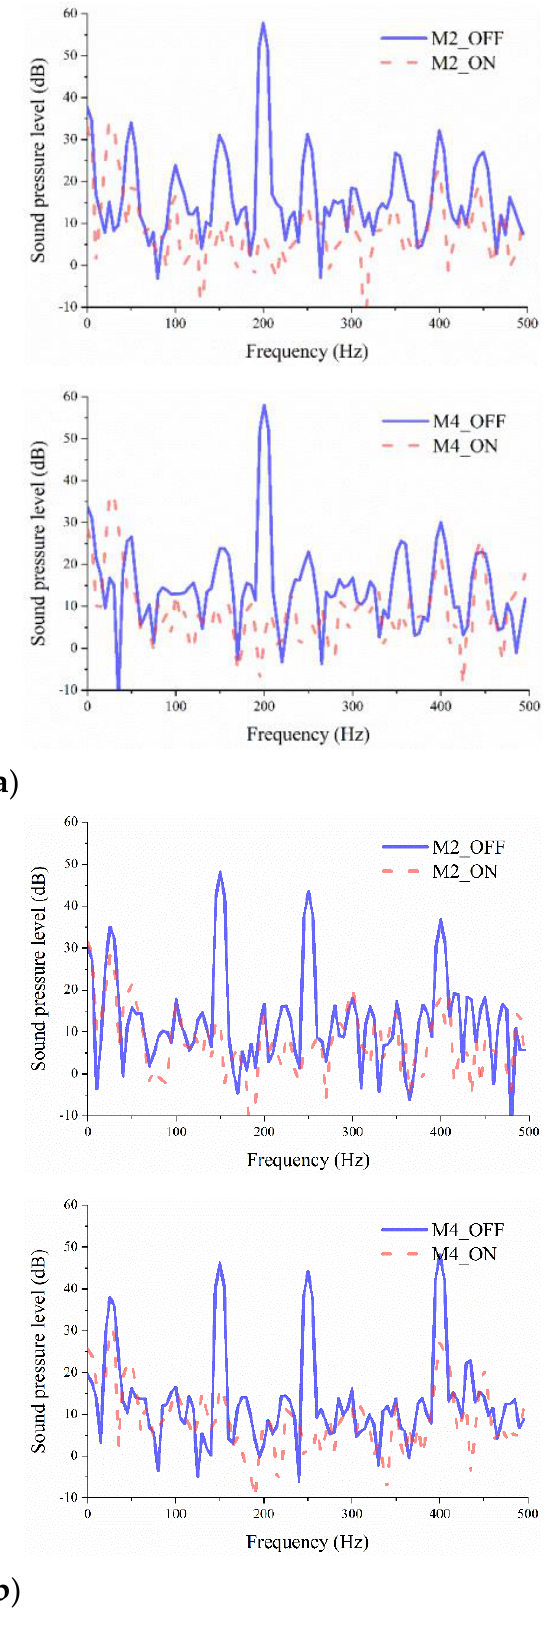
tion reached 28 dB. The noise cancellation for the mixed frequency noise source was not as great as for the single frequency source because of the increase of the signal complexi- ty, but the average noise cancellation reached 17 dB. After the ANC was turned on, the sound pressure level of the noise was immediately reduced, finally reaching a stable state at approximately 30 dB. The frequency spectrum in Figure 11 shows that the sound pressure level of the noise at the frequency where the noise was the main contribution was greatly reduced after the algorithm was turned on, whereas the sound pressure lev- els at other frequencies did not show large improvement.